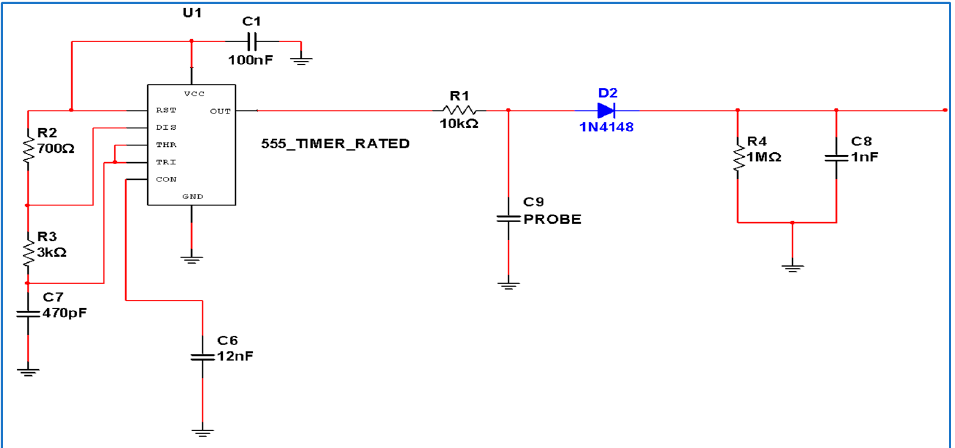
Figure 1. Schematic diagram of capacitive soil moisture sensor circuit.